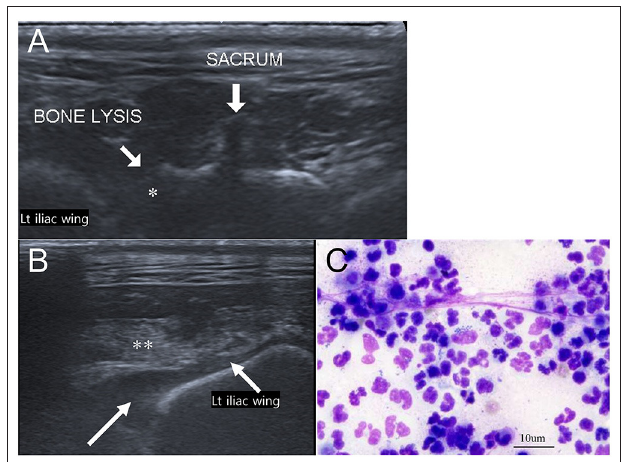
FIGURE 4 | Musculoskeletal ultrasound images of the sacroiliac joint (A,B) and cytologic evaluation of aspirated trapped fluid around the iliac wing (Wright-Giemsa stain, × 400 magnification) (C) . (A) Adjacent to left iliac wing, lytic changes of left sacral bone (asterisk) is noted. (B) Trapped anechoic fluid (white long arrow) and hyperechoic muscle (double asterisk) are found in the retroperitoneum near left iliac wing. (C) Cytologic evaluation indicates numerous degenerated neutrophils and phagocyted